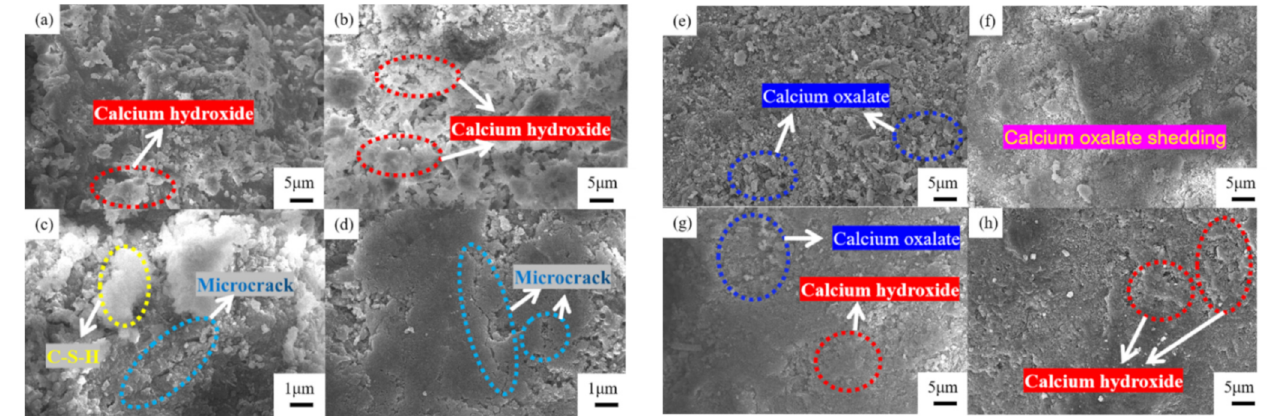
Figure 16. Changes in surface micro-morphology of steel slag under different water erosion times: untreated after ( a ) 1 day, ( b ) 4 days, ( c ) 7 days and ( d ) 10 days; and treated after ( e ) 1 day, ( f ) 4 days, ( g ) 7 days and ( h ) 10